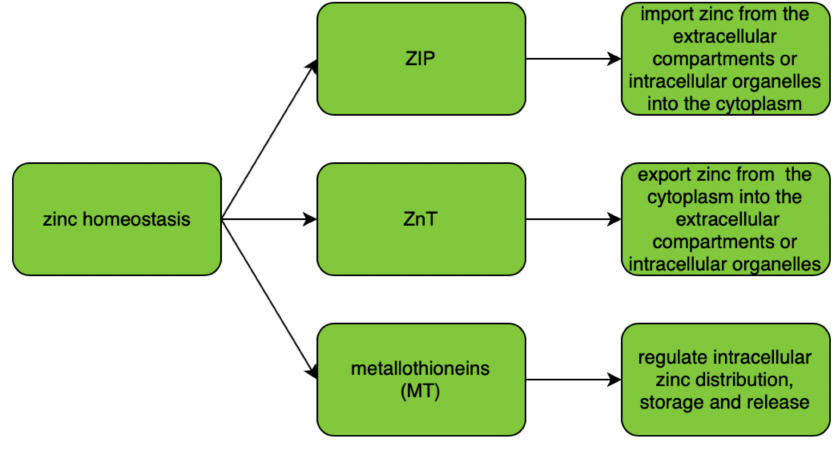
Figure 1. Regulation of zinc